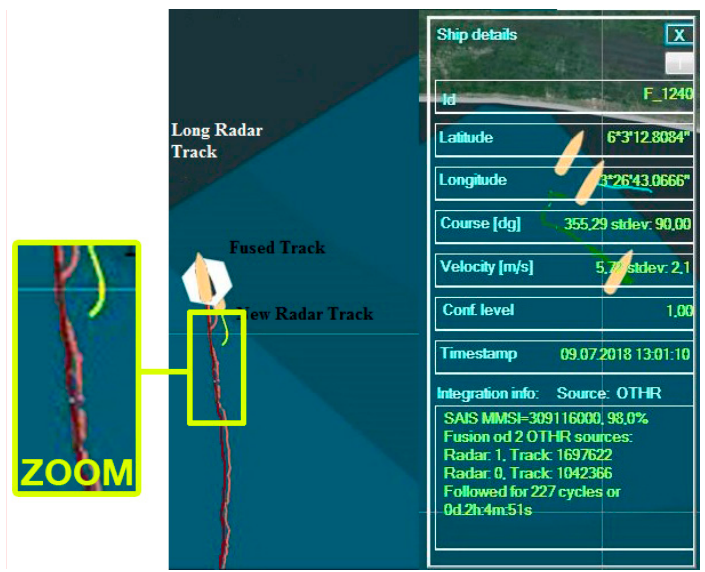
8 of 13 Figure 4. Case” (dark blue trace: radar 0 data, green trace: radar 1 data, purple trace: fused track, red trace: AIS data). Fused track id No. F_155 consists of radar 0 track id No. 0_116175 and radar 1 track id No. 1_94725. Both radars are providing stable and long-lasting tracks with minimal position differences so the data fusion process is quite simplified. Moreover, there is only one AIS target nearby (MMSI 636014250) which further justifies the data fusion decision. The confidence level is listed in the fused